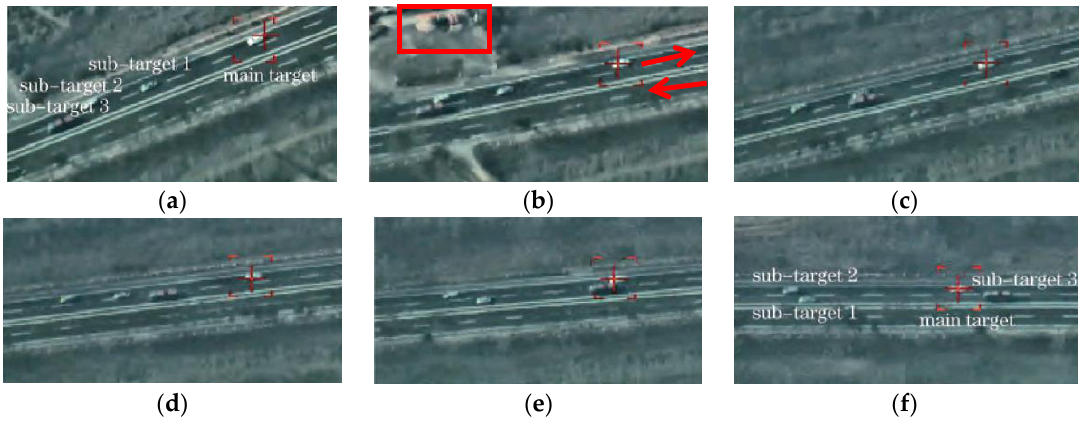
Figure 16. Multiple moving targets in aerial video. ( a – f ): frame1, frame 3, frame 4, frame 6, frame 7, frame 9.